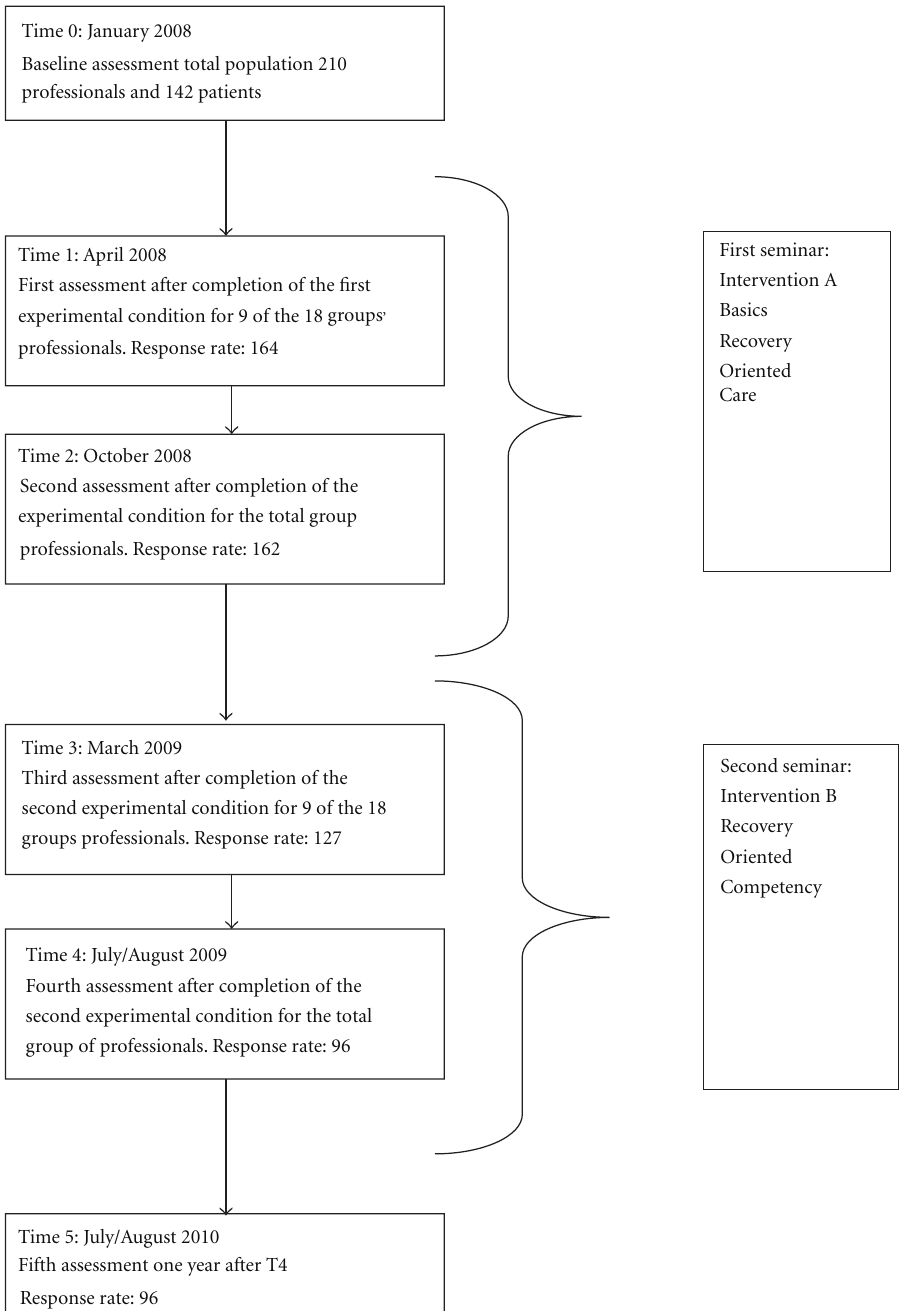
Figure 1: Flowchart of the training and measurements